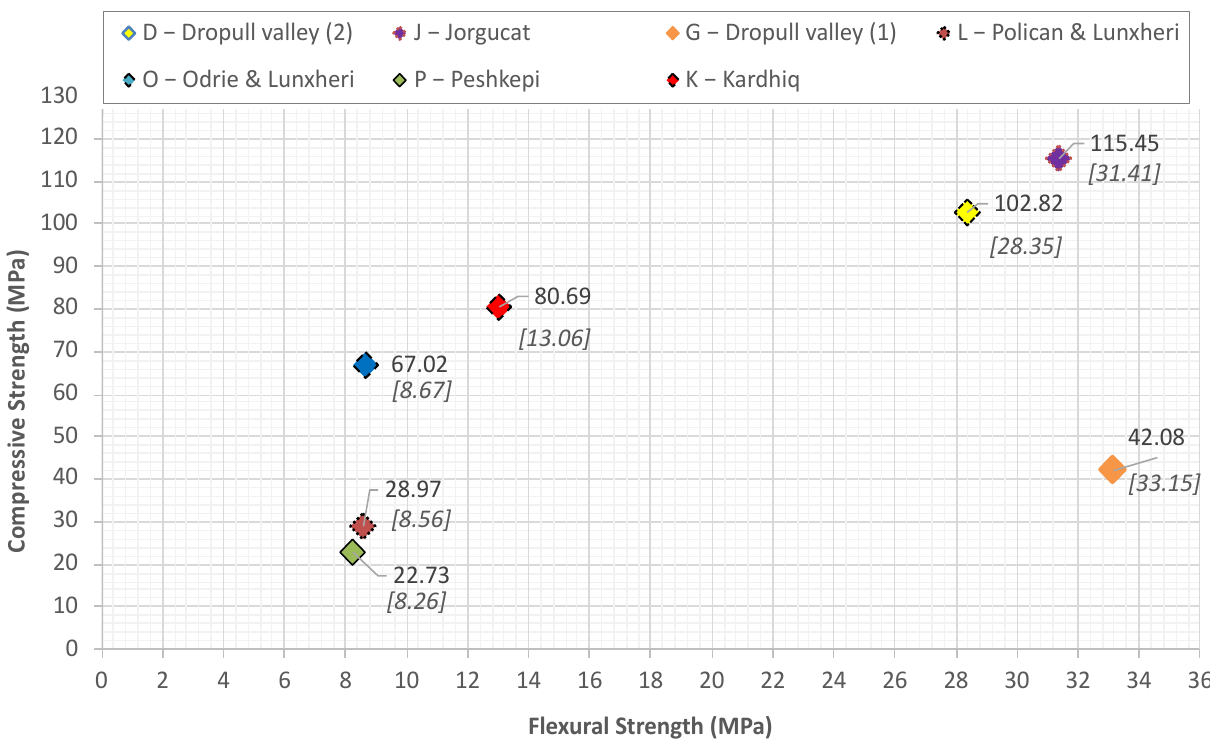
12 of 21 Figure 10. The schematic representation of the testing procedure (dimensions in mm). 4.2.2. Compressive Strength The compressive strength test was performed in accordance with EN 1926 [42]. It is defined that the test specimens were cut in cubes with (70 ± 5) mm or (50 ± 5) mm edges or right circular cylinders with diameter and height equal to (70 ± 5) mm or (50 ± 5) mm. In Figure 9 are presented the stone prisms before testing. For this study, the specimen cubes were (70 ± 5) mm in size. Three samples were tested for each stone type and the average compressive strength value was calculated. The compressive strength is calcu- lated by the formula in equation 2, where F is the applied load in N and A is the resisting area in mm 2 . 𝜎 (cid:3030) = (cid:3007) (cid:3278) (cid:3029)(cid:3035) , (2) In Figure 11 are plotted the compressive strength and flexural strength of the tested specimens. According to the test results the flexural strength values vary from 8 to 33